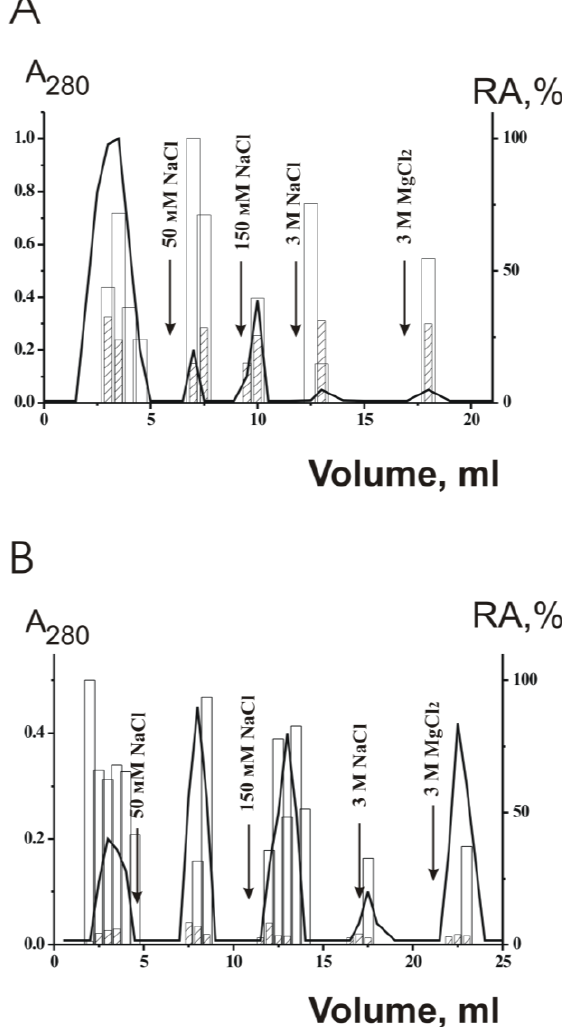
FIGURE 2. Affinity chromatography of polyclonal human milk IgGs (A) and sIgAs (B) on ATP-Sepharose: (  ), absorbance at 280 nm (A and B)[139]. The relative lipid kinase activity (RA) of the Ab fractions eluted from the resin by different concentrations of NaCl and 3 M MgCl 2 was estimated in the presence of [  - 32 P]ATP and [ 32 P]orthophosphate (white and gray bars, respectively). The highest RA among the fractions was taken for